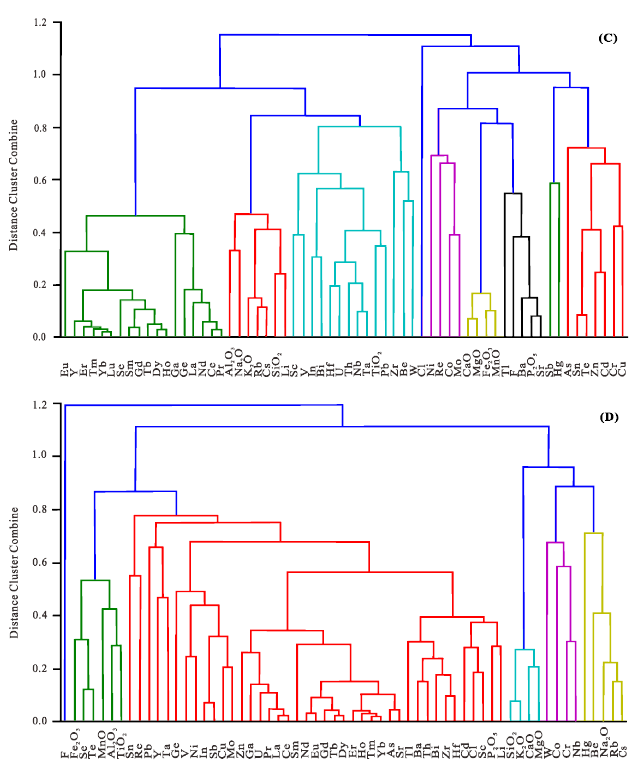
Figure 2. Cluster analysis for coal element data from the Adaohai mine. ( A ) Improved alr on coal and ash basis; ( B ) Geboy’s approach on coal and ash basis; ( C ) clr on coal and ash basis; ( D ) ilr on coal and ash basis.